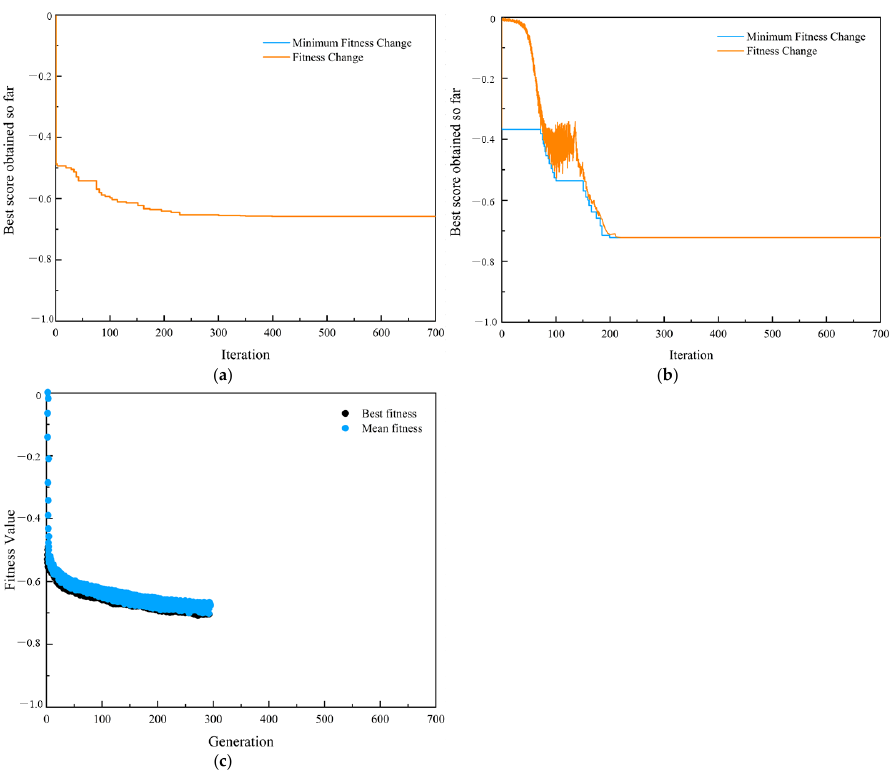
Figure 7. The iterative process of each algorithm when aiming at the maximum availability. ( a ) Convergence curve of PSO algorithm, ( b ) convergence curve of SAA, ( c ) convergence curve of GA. Figure 7a–c show the convergence curves of the PSO algorithm, SAA and GA, re ‐ spectively, when aiming at the maximum availability. The results of each algorithm under different decision objectives are shown in Table 2. Table 2. The results of each algorithm.